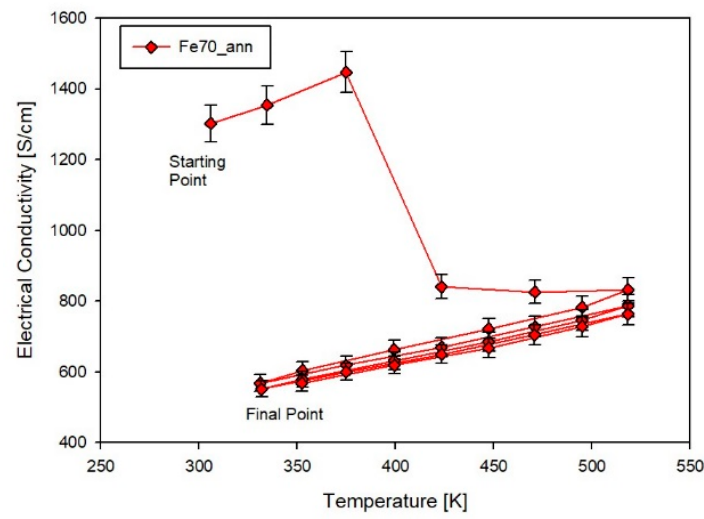
Figure 9. Electrical conductivity measurement cycles performed on sample Fe70_ann. Lines are guides to the eye.